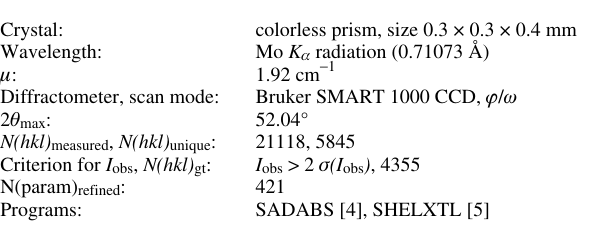
Table 1. Data collection and